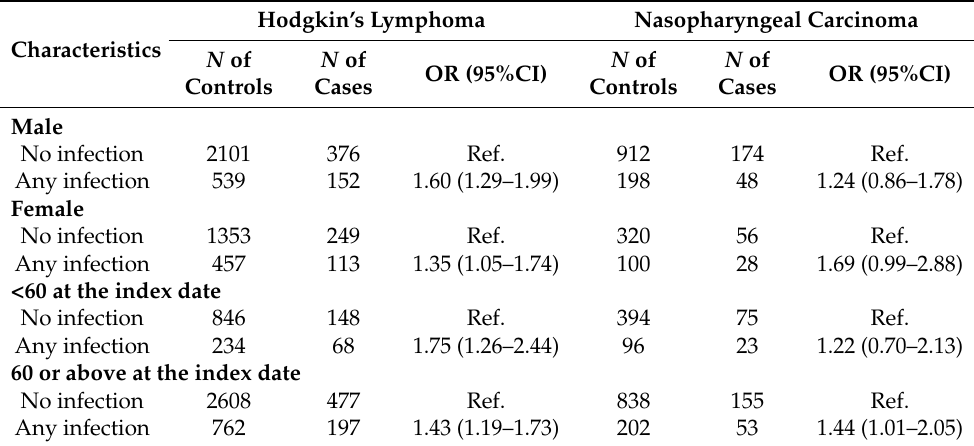
Table 3. Odds ratios (ORs) and 95% confidence intervals (CIs) of EBV-related malignancies in relation to hospital-treated infections >3 years before malignancy diagnosis, stratified analysis by sex and age. Hodgkin’s Characteristics